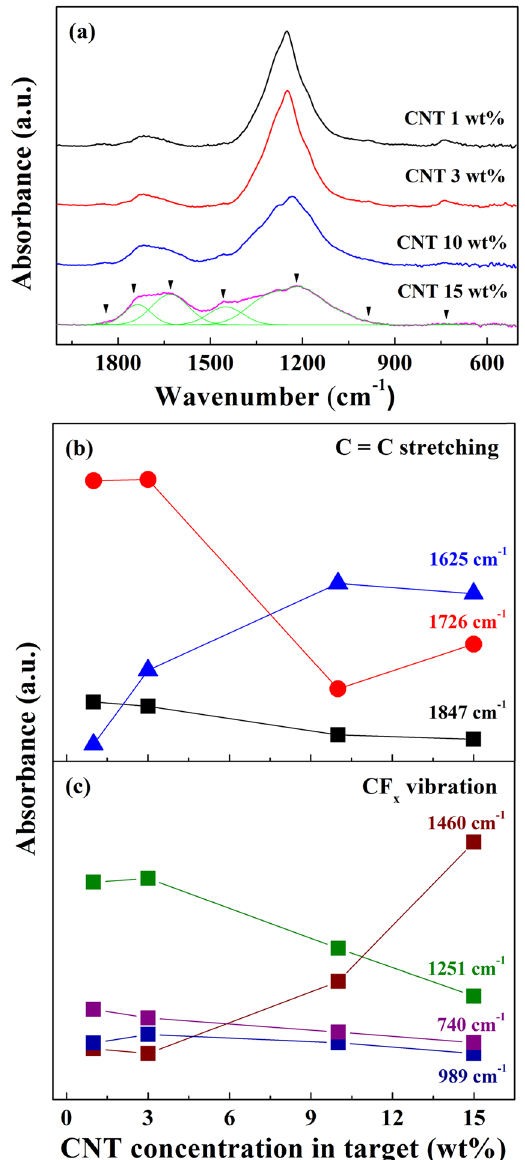
Figure 6. ( a ) FT-IR reflectance absorption spectra of the fluorocarbon thin films. Intensity changes in the reflectance absorption of ( b ) C = C stretching and ( c ) CF x vibration modes. To compare easily, 1251 cm − 1 (green) was 5 times